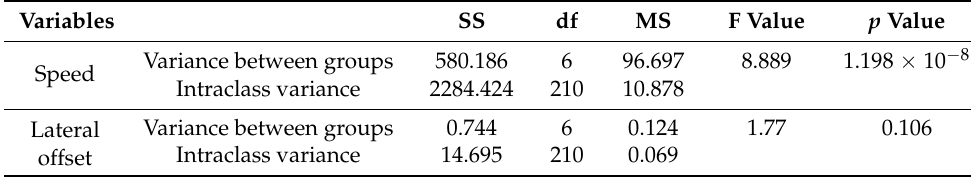
Table 15. Variance analysis of the relationship between driving behavior and slope. Variables Variance between